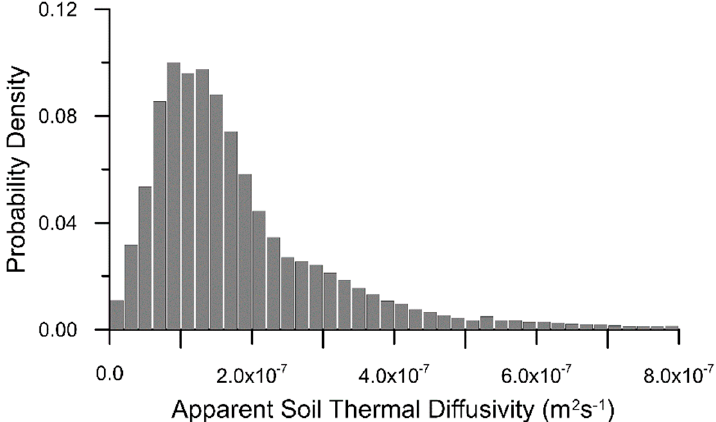
Figure 15. Probability density of Apparent Thermal Soil Diffusivity at CDGr.